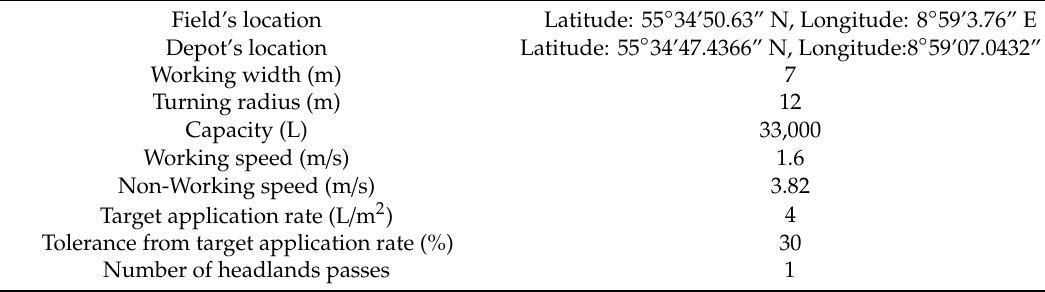
Table 5. Input data for the optimization and simulation models.